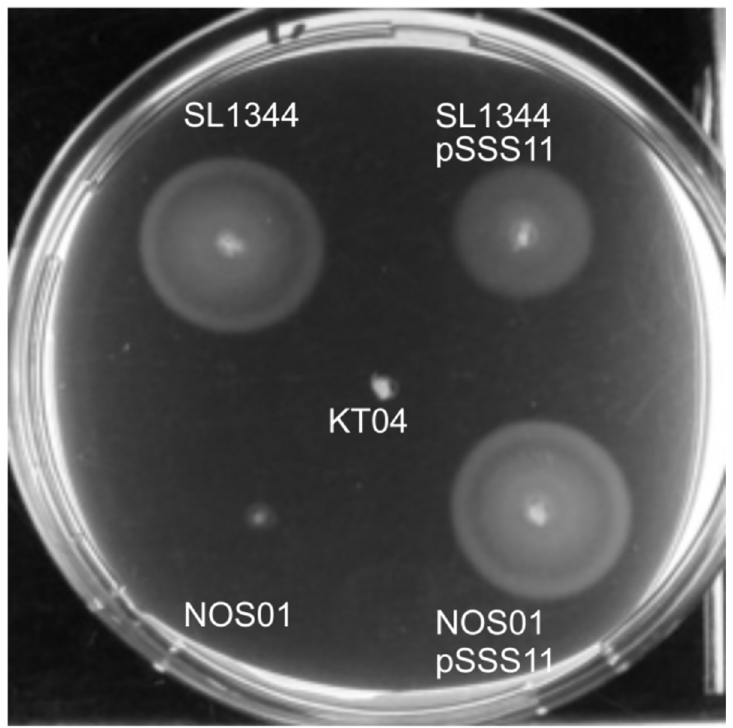
Fig 4. S . typhimurium is immotile in the absence of CpxR. An equal number of freshly grown S . Typhimurium wild type SL1344, the cpxR mutant NOS01, and the cpxRA overexpressing strains SL1344 < pSSS11 > and NOS01 < pSSS11 > was spotted onto tryptone swarm soft agar plates pH 8.0 at 30˚C for 10h. KT04 (SL1344 fliC , fljB ) was used as negative control.